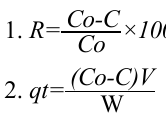
mg/L. This calibration curve was used to determine the equilibrium concentration of methyl orange dyes in order to calculate the degree of dye output. The results have been shown in Figure 2.